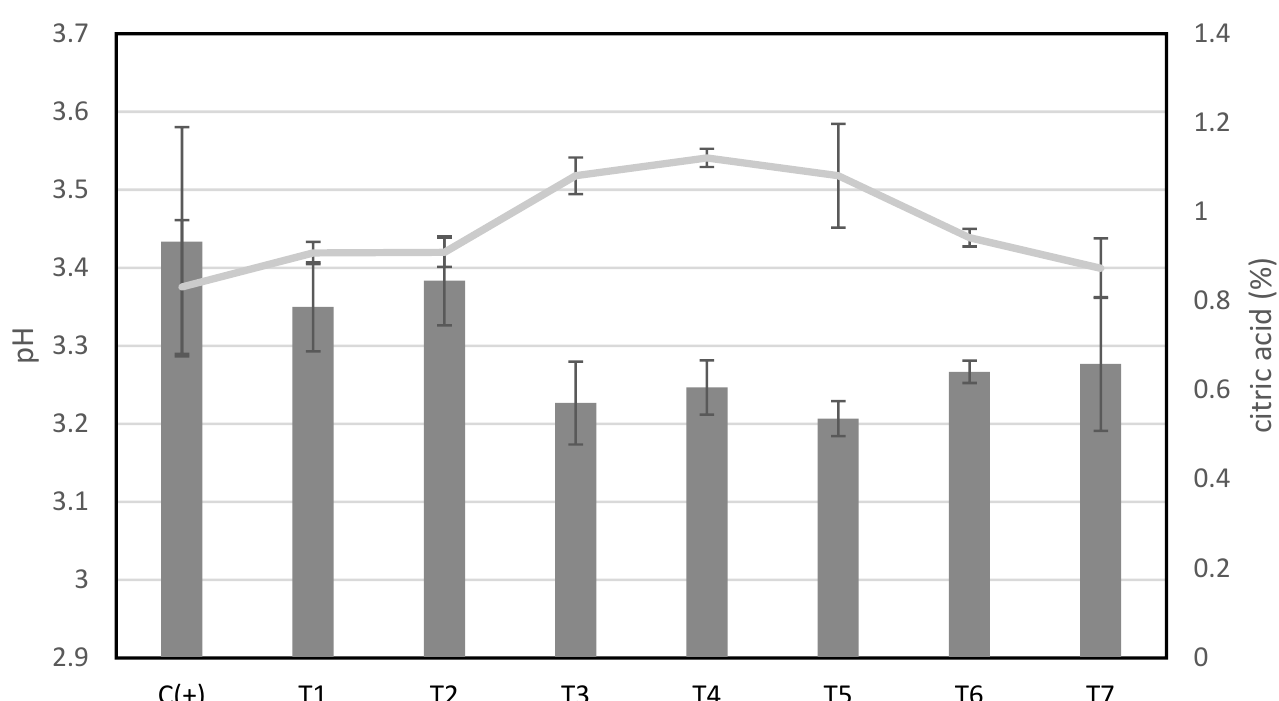
Figure 4. pH and acidity determined at day 5 of storage with refrigeration in mango wedges treated with different antimicrobial cocktails. Legend: Control (+): mango wedges + FSBM; T1: (Cys5-4+ Gt28)CFS: 1:1 ( v/v ); T2: (Cys5-4+ Gt28) CFS: 1:3 ( v/v ); T3: (Cys5-4+ Gt28)CFS: 3:1 ( v/v ); T4: (Cys5-4+ Gt28)PP: 1:1 ( v/v ); T5: (Cys5-4+ Gt28)PP: 1:3 ( v/v ); T6: (Cys5-4+ Gt28)PP: 3:1 ( v/v ); T7: Nisin (50 μ g/mL);